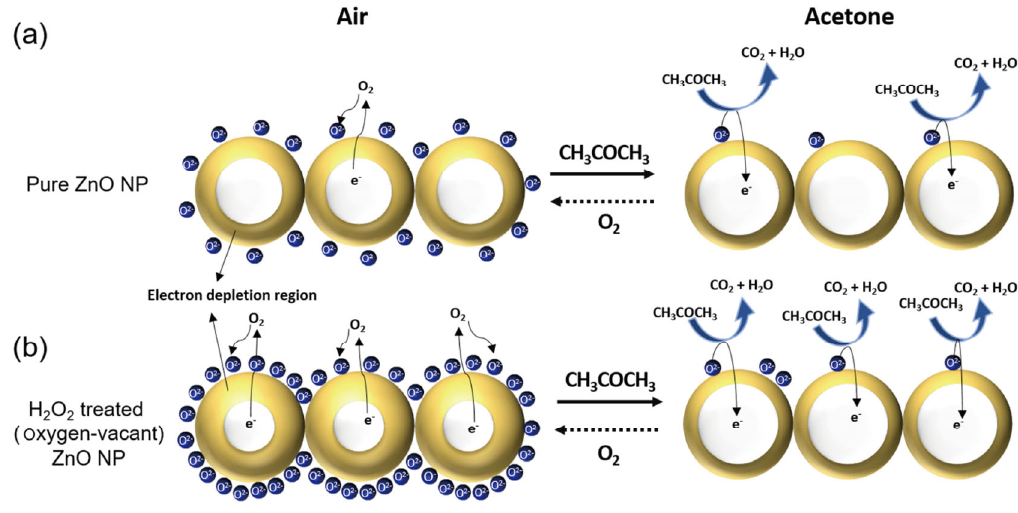
Fig. 11 Schematic illustration of the sensing reaction mechanism of (a) commercial ZnO NPs and (b) H 2 O 2 treated/annealed (oxygen-vacant) ZnO NPs in air and